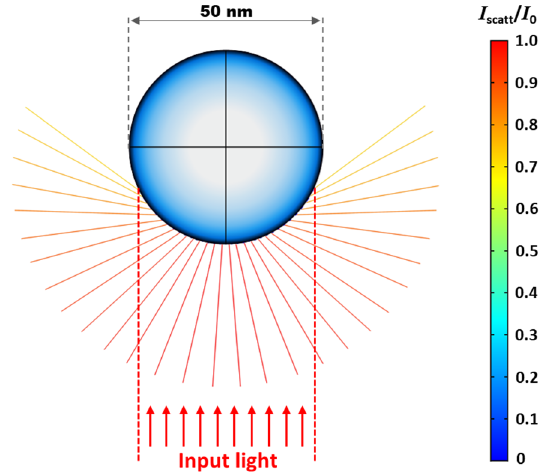
Figure 2. Simulation results of plasmonic light scattering by a spherical nanoparticle with a diameter of 50 nm. A total of 500 input rays are assumed to be illuminated from the bottom. Upon hitting the nanoparticle, these rays are scattered over a high angular spread, thereby increasing their optical path lengths. The intensity of each scattered ray is also observed to vary according to the direction of scatter. The larger the direction of scatter, the lower the scattered intensity of the ray ( I scatt ) as compared to the input ray ( I 0 ). A color scale bar indicates the intensity ratio between the scattered and input ray, i.e., I scatt / I 0 .